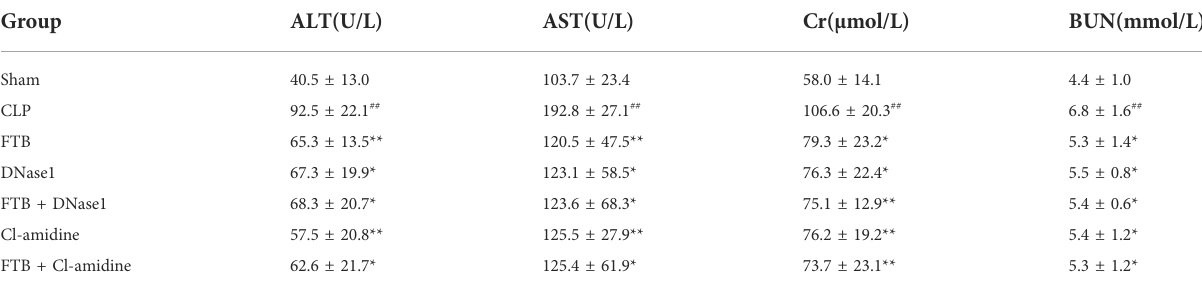
TABLE 3 Changes in ALT and AST activities, Cr and BUN levels after FTB, DNase1 and Cl-amidine treatment. Group ALT(U/L)